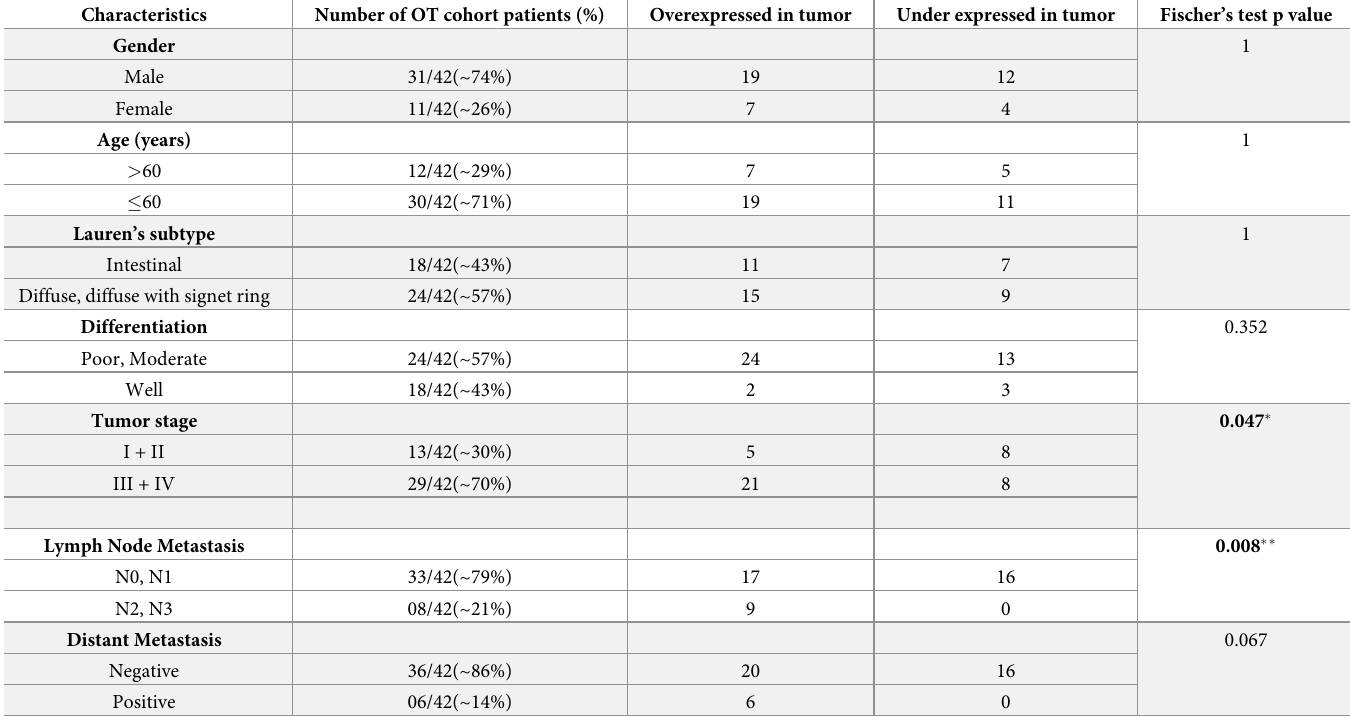
Table 1. Demographic table of OT cohort